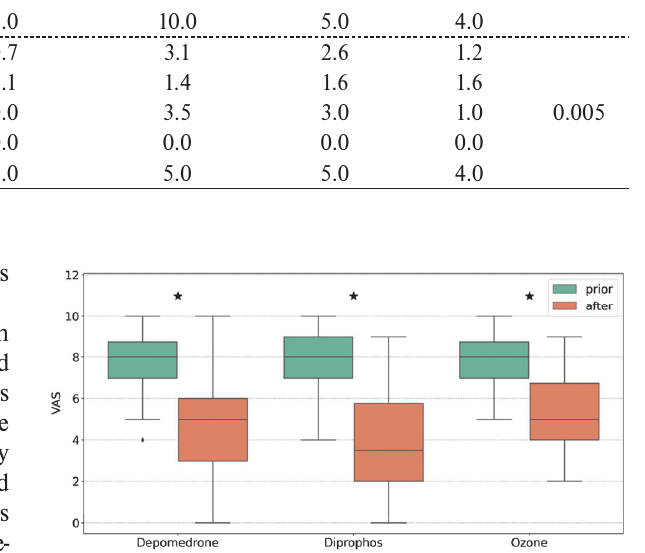
Fig. 1. Grouped boxplots showing the distribution of VAS for in- dividual drugs prior to and after therapy. The asterisks denote a statistically significant ( P <0.001) difference between VAS prior to and after therapy for each group.